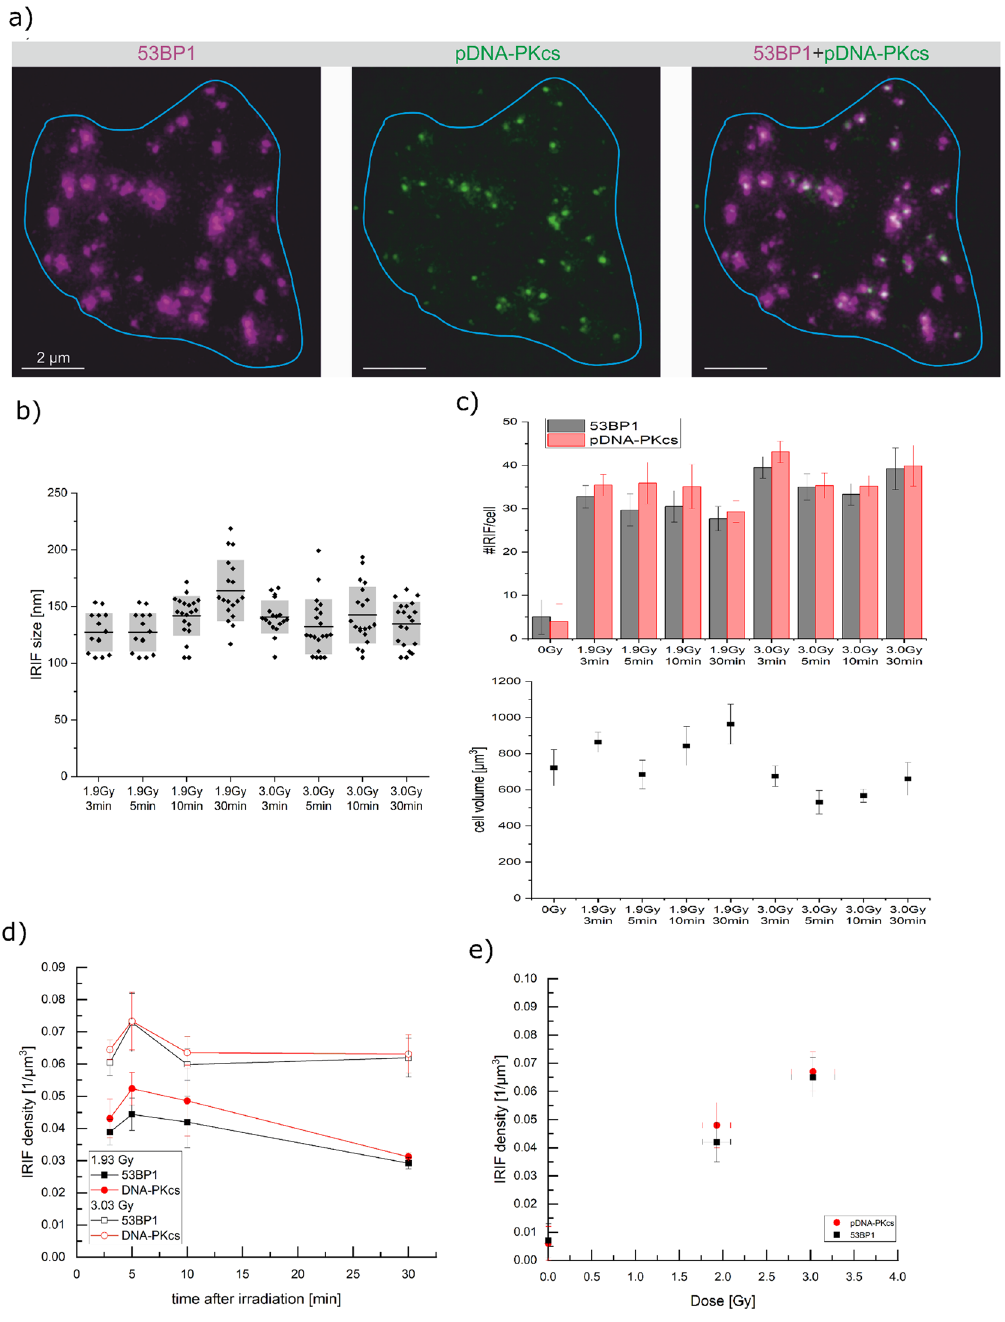
Figure 1. ( a ) 2D section of a HeLa cell nucleus irradiated with 3.0 Gy γ-radiation. The blue line represents the cell nucleus. For each 53BP1 IRIF (magenta), at least one pDNA-PKcs IRIF (green) is located inside the 3D stack. This 2D slice shows some 53BP1 IRIF where the corresponding pDNA-PKcs IRIF is in another slice above or below. The larger 53BP1 IRIF contain two or more pDNA-PKcs IRIF. ( b ) IRIF size determined for each dose and time point. ( c ) The upper panel shows the number of IRIF per cell for 53BP1 (black) and pDNA-PKcs (red) for each dose and time point. The lower panel depicts the corresponding nuclear volume. The radiated samples show significantly more IRIF per cell, but no significant difference is visible for the irradiation geometries. The raw data box plots can be found in Supplementary Fig. 2. Cell volume measurements reveal that a large difference can be seen between the radiation geometries. Therefore the pure counting is not feasible in this case. ( d ) IRIF density for γ-irradiation over time. For all time points, the IRIF density is significantly higher for 3.0 Gy than after 1.9 Gy irradiation. Throughout the whole period, the number of 53BP1 and pDNA-PKcs IRIF do not differ significantly for both irradiation doses but are slightly higher for pDNA-PKcs at all times ( e ) mean IRIF density over